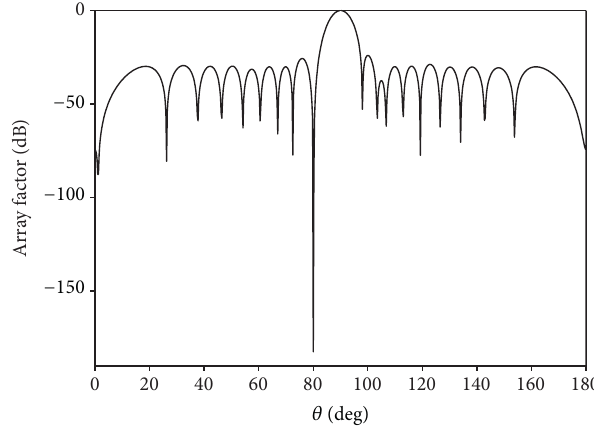
Figure 5: Radiation pattern obtained by phase-only control with one imposed null at 80 ∘